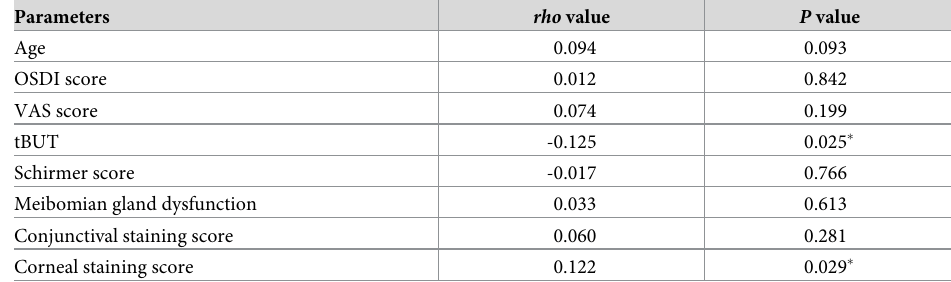
Corneal staining score 0.122 0.029 � MMP-9, matrix metalloproteinase-9; OSDI, ocular surface disease index; VAS, visual analogue scale; tBUT, tear break-up time. � Statistically significant by the linear Spearman’s rank correlation test.